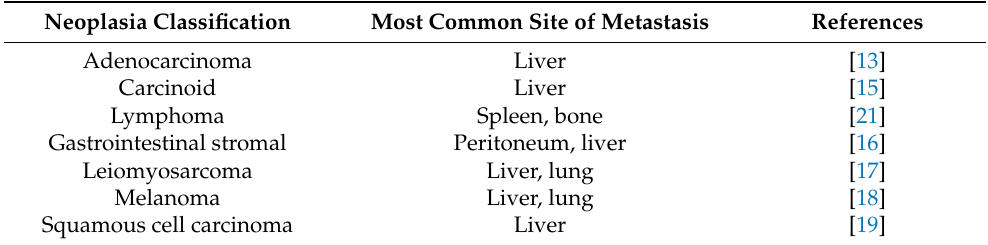
Figure 1. Most common sites of metastasis of colorectal neoplasia specific tumor type. Figure created using biorender. Table 1. Colorectal neoplasia classifications and their most common metastatic sites.